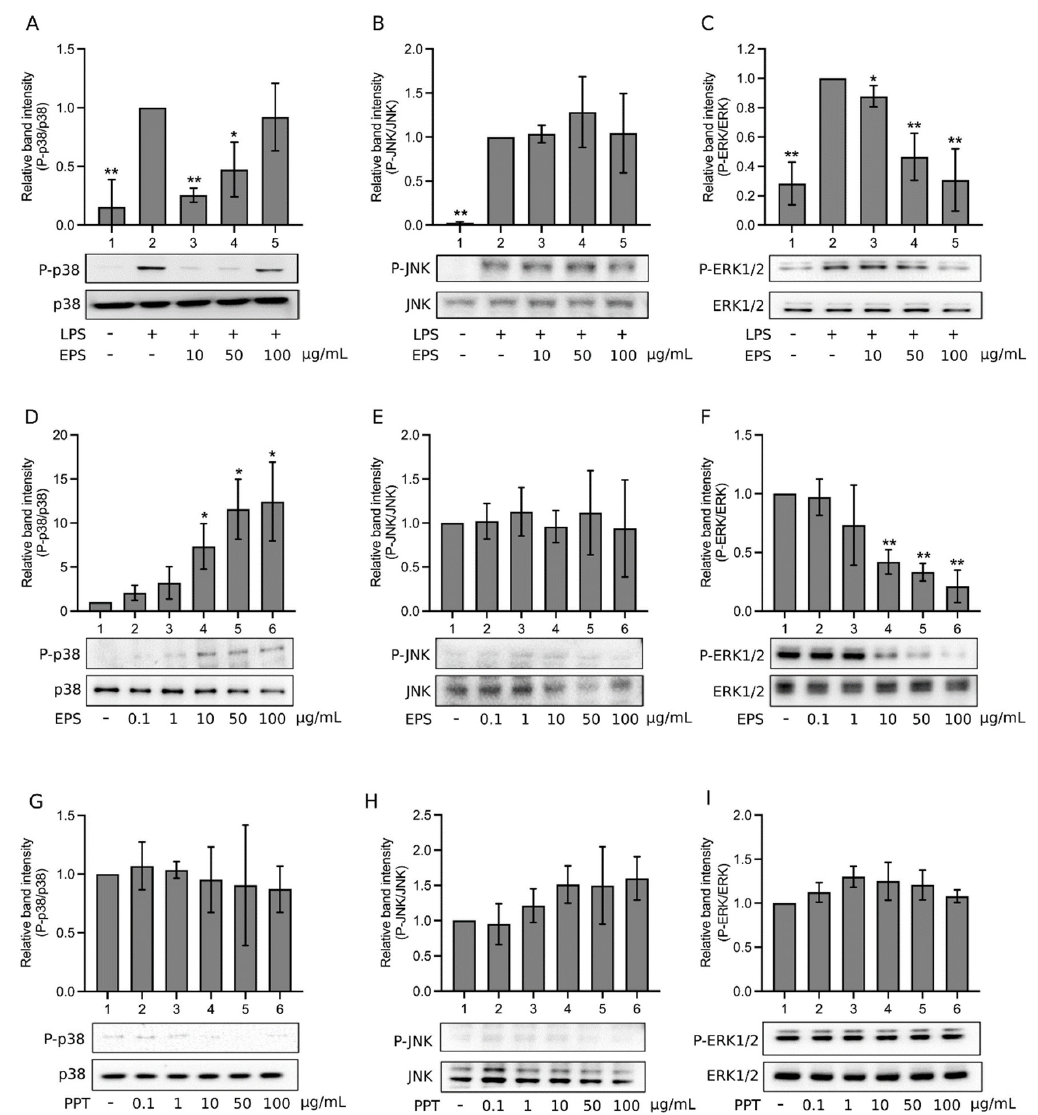
Figure 5. The effects of EPS on mitogen-activated protein kinases (MAPKs). ( A – C ) THP-1 cells were treated with vehicle (Lane 1), 1 µ g/mL LPS (Lane 2), or LPS and 10, 50, or 100 µ g/mL EPS (Lanes 3–5) for 1 h. ( D – F ) THP-1 cells were treated with vehicle (Lane 1) or 0.1, 1, 10, 50, or 100 µ g/mL